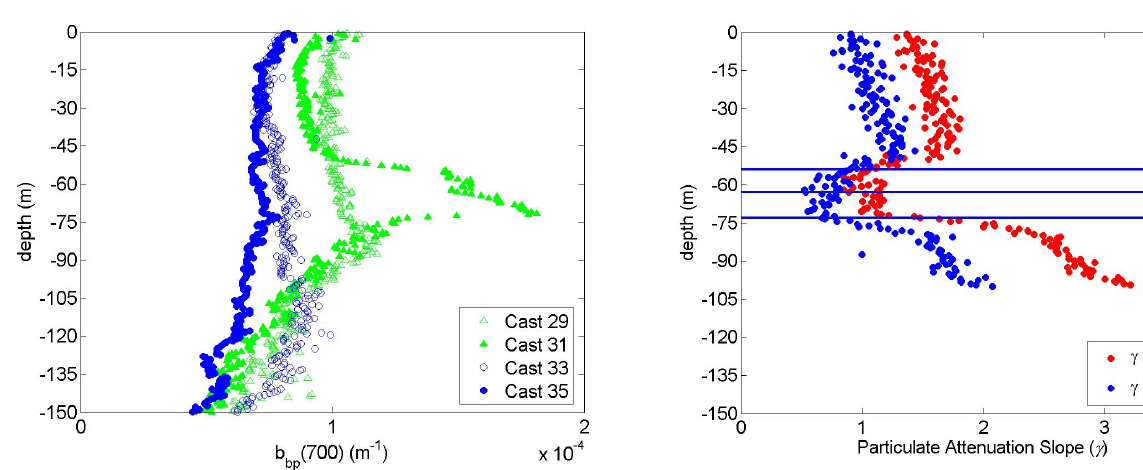
Fig. 11. Vertical profiles of PSD slope [ γ ] computed using the mea- sured c pg (red), and the corrected c p (blue), for Cast